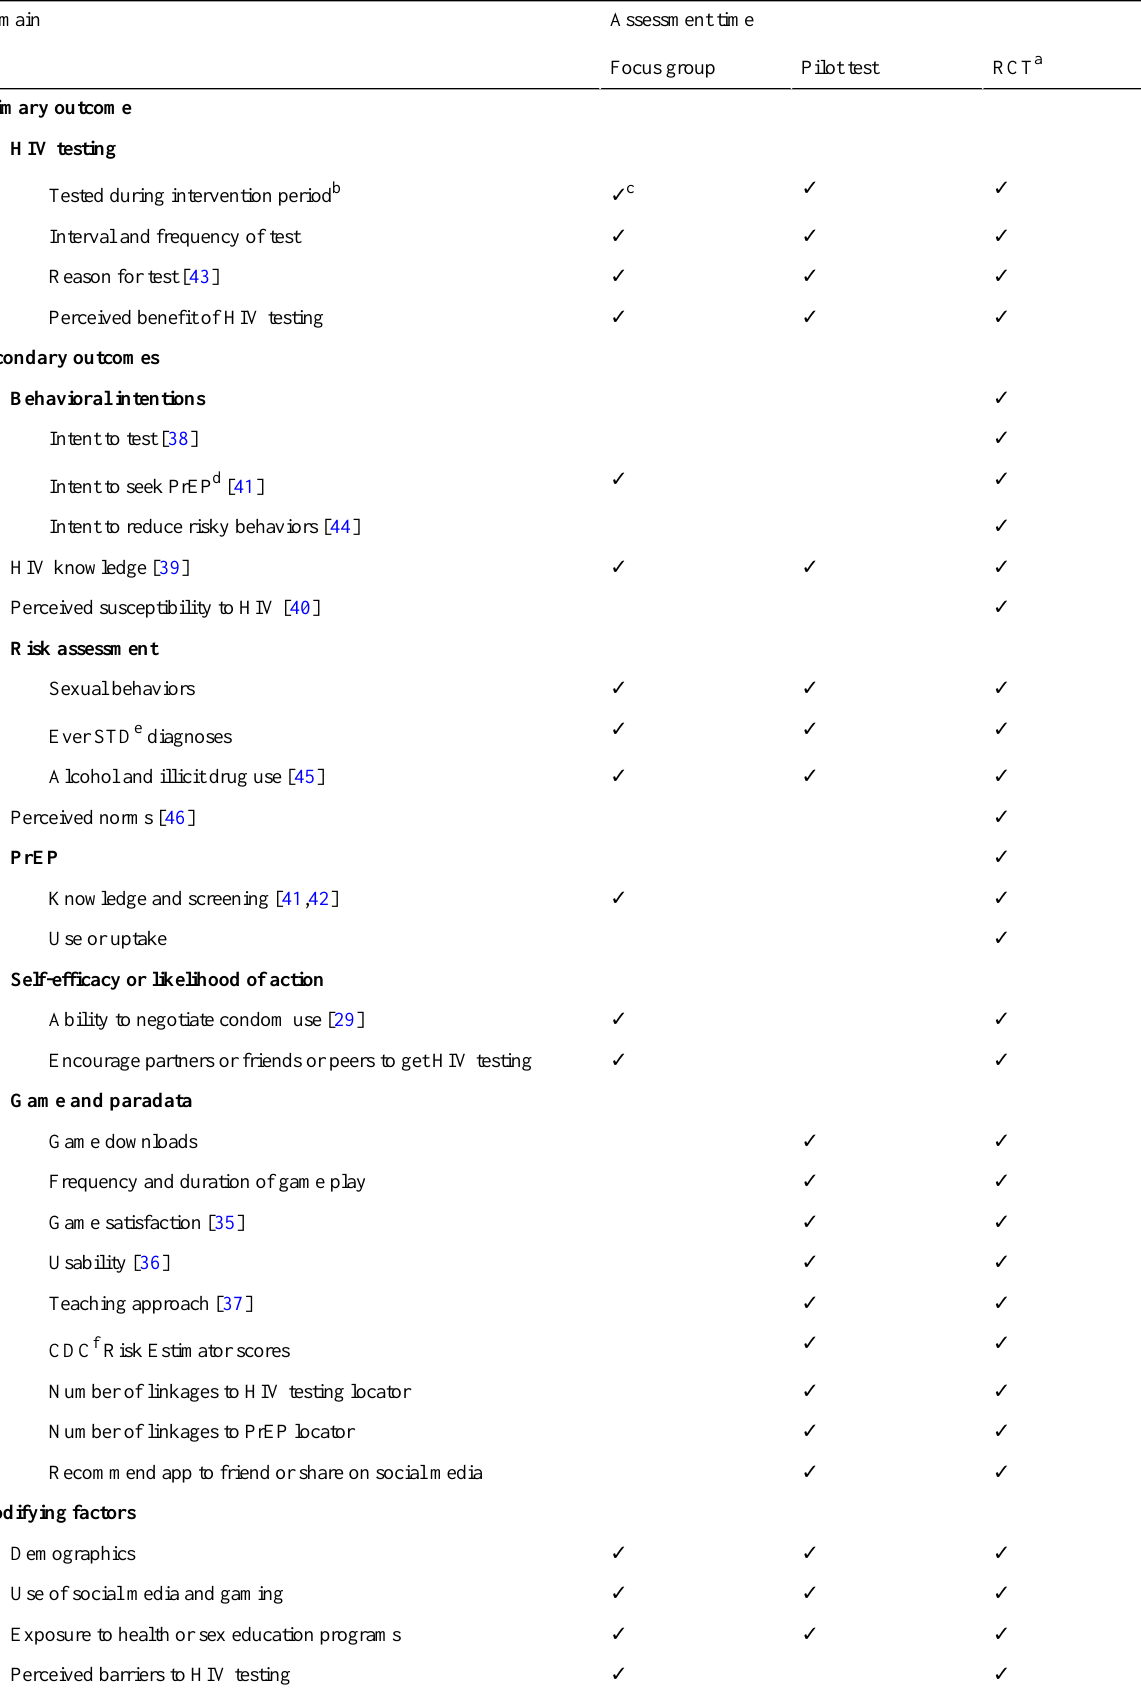
Table 1. Measures planned for each